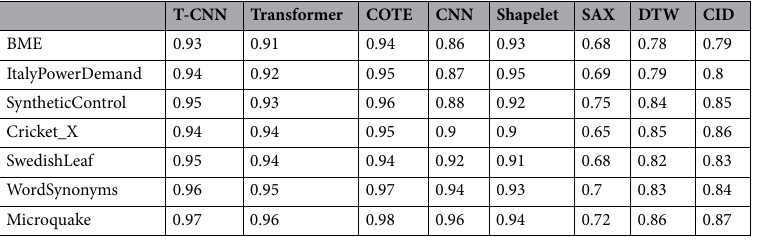
Table 5. Comparison of classification recall.